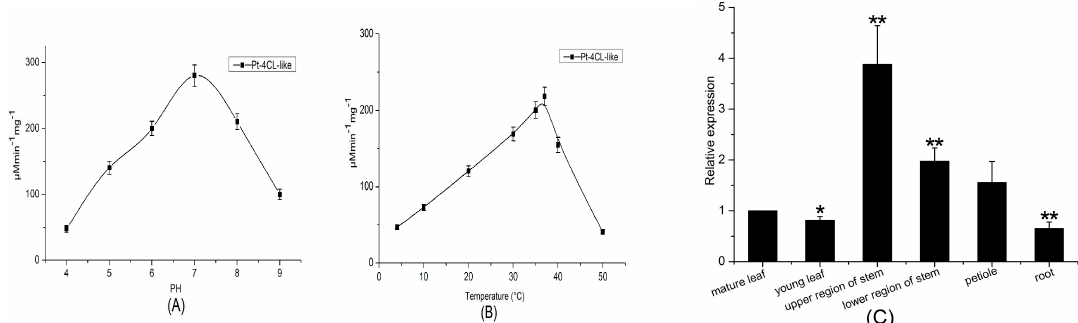
Figure 7. Biological activities of the purified Pt4CL-like enzyme. ( A ) Catalytic activity of recombinant Pt4CL-like enzyme under different pH conditions. ( B ) Catalytic activity of recombinant Pt4CL-like